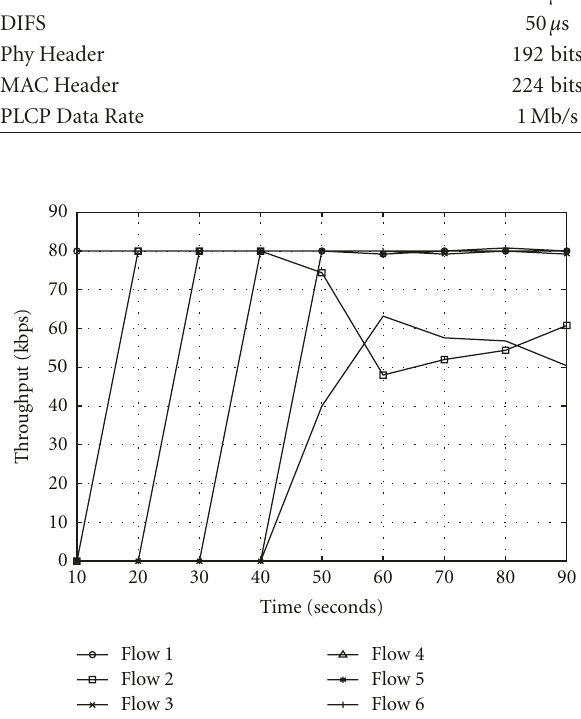
Figure 10: Throughput of six flows versus time when no admission control algorithm is employed. RTS/CTS mechanism is used.